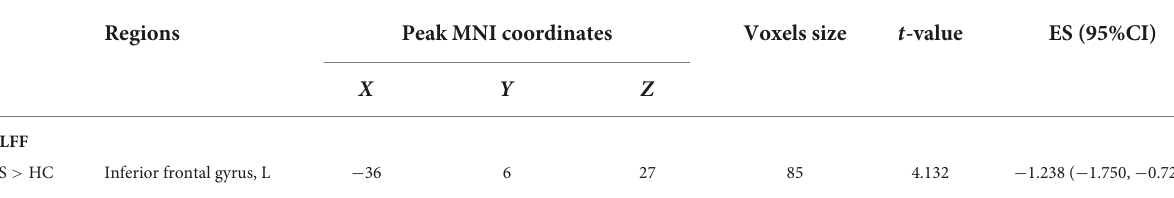
TABLE 2 Significant differences in ALFF between two groups. Regions